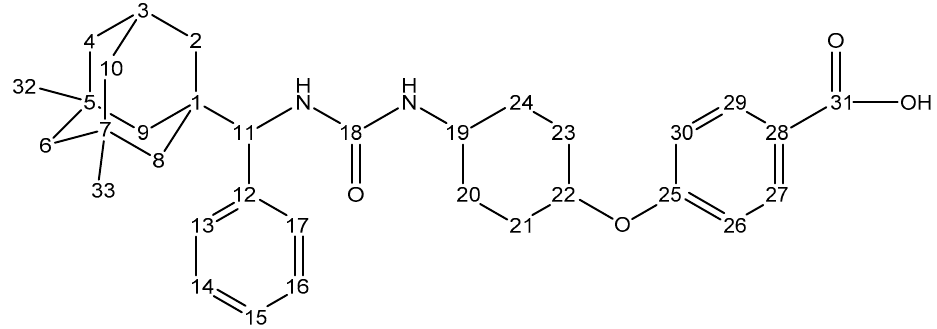
Figure 4. Carbon atoms labeled for compound 8k .